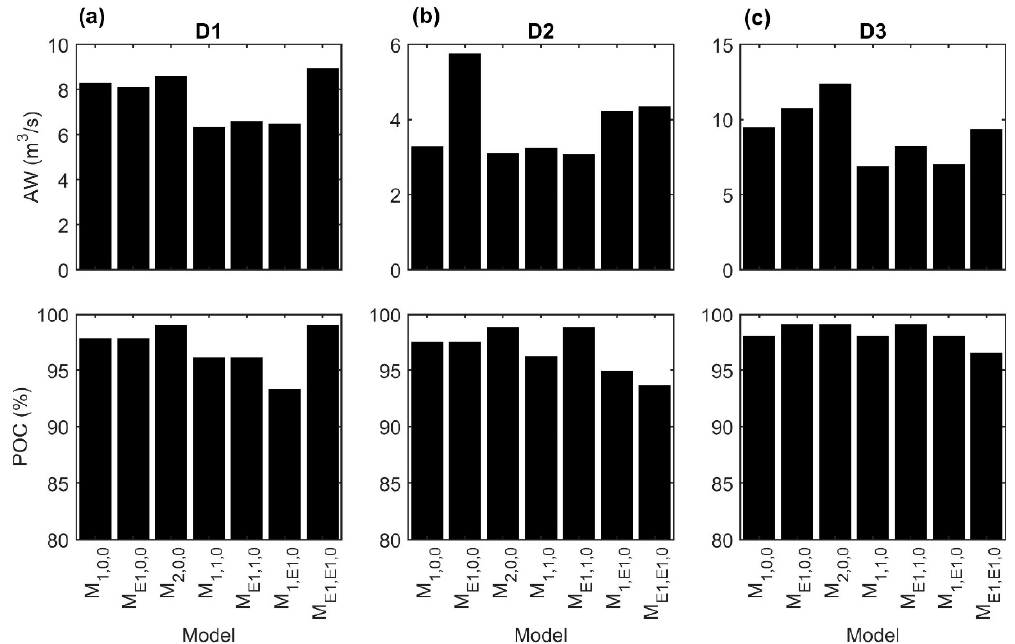
Figure 2. Uncertainty metrics (average bandwidth ( AW) and percentage of coverage (POC ) of the candidate nonstationary models for the datasets, ( a ) D1, ( b ) D2, and ( c )